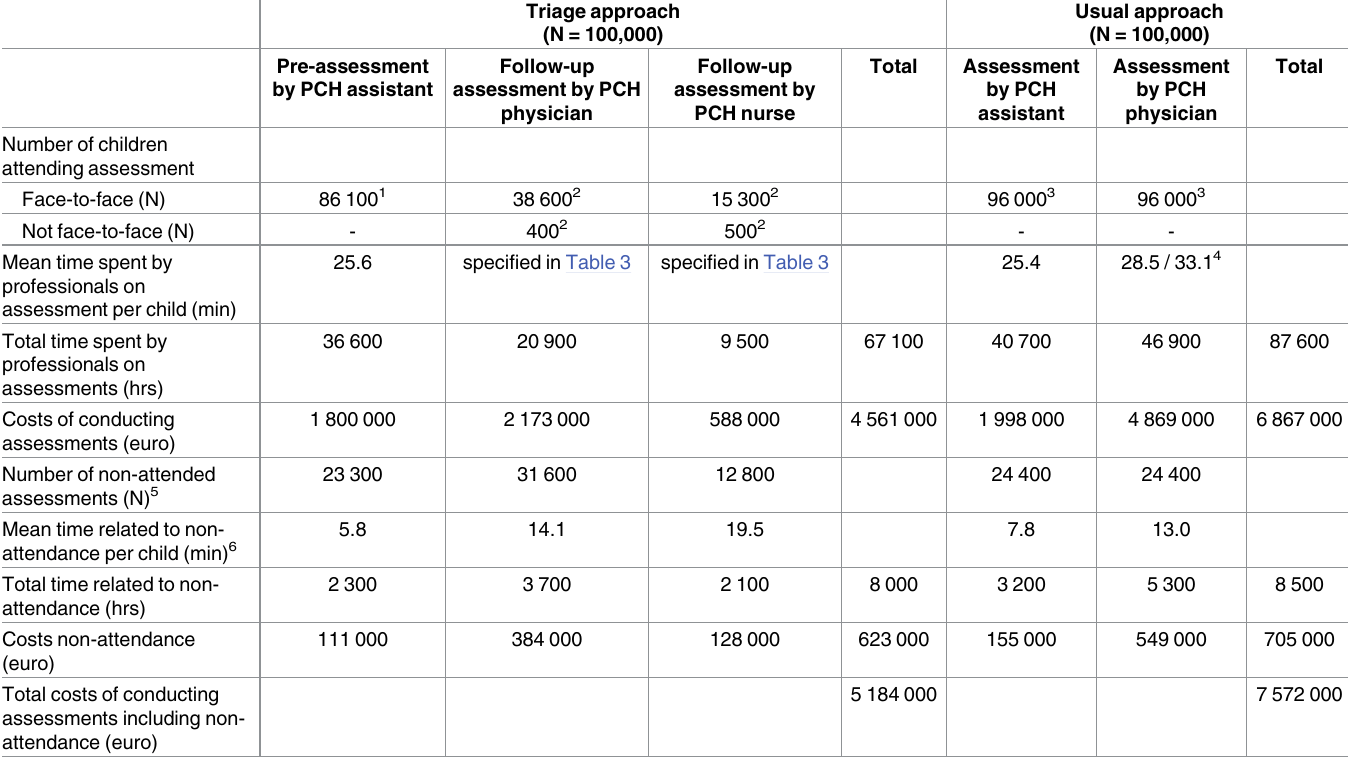
Table 1. Costs (2013 € ) associated with the time spent by PCH professionals on preventive assessments of child health in the triage approach and the usual approach for children aged 5/6 yearson the basis of a theoretical cohort of 100,000children per year.